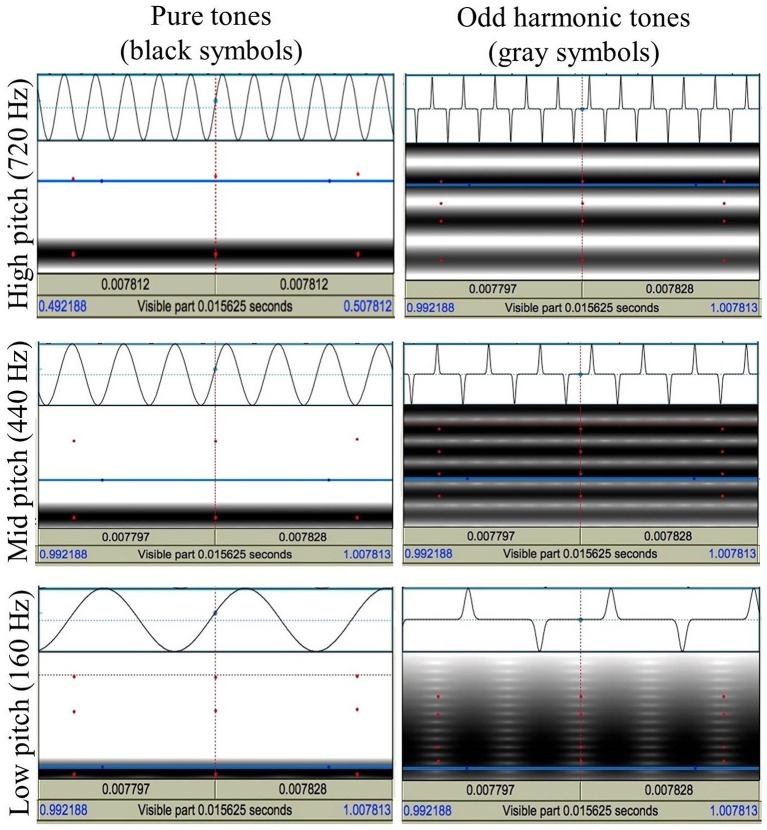
Waveform and spectrogram excerpts describing the pitch (720, 440, 160 Hz) and timbre (pure tone, odd harmonic tone) characteristics of the sound stimuli. Images generated in Praat (Boersma and Weenink, 2014).